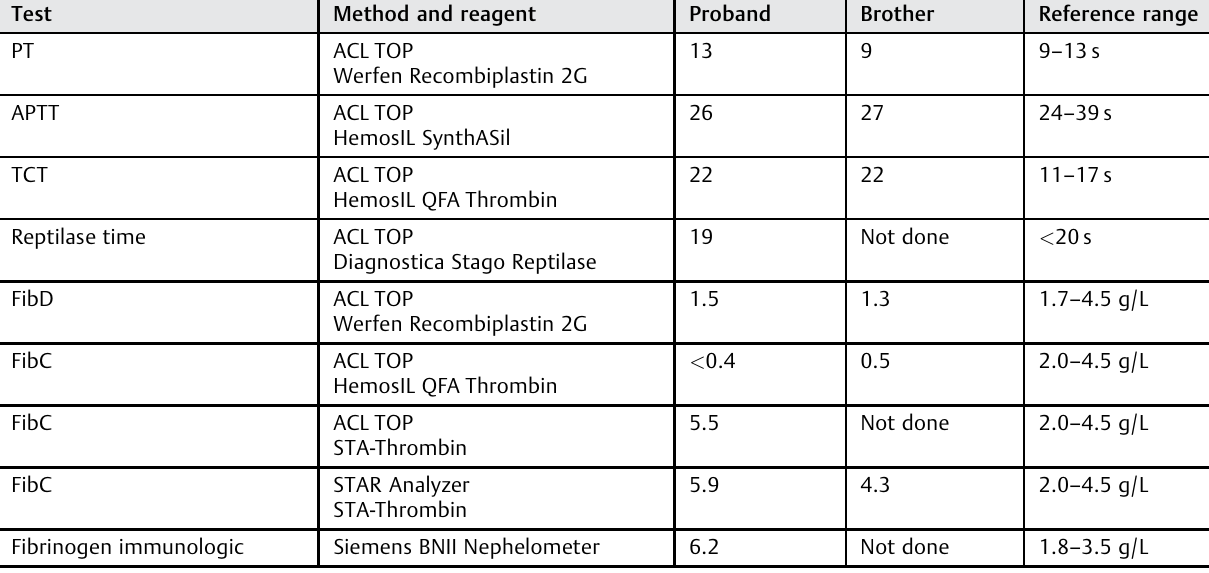
Table 1 Coagulation assays of proband and brother at